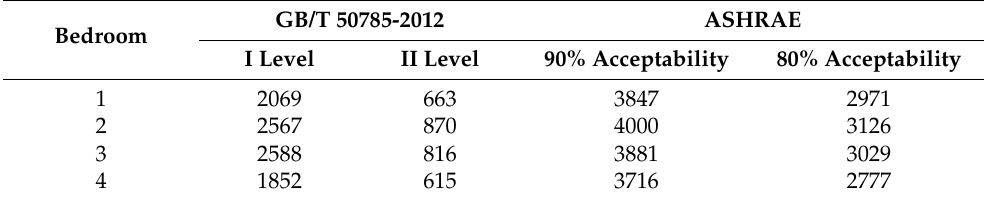
Figure 8. Overall indoor thermal comfort with natural ventilation. Table 4. Uncomfortable durations with natural ventilation (unit: h).